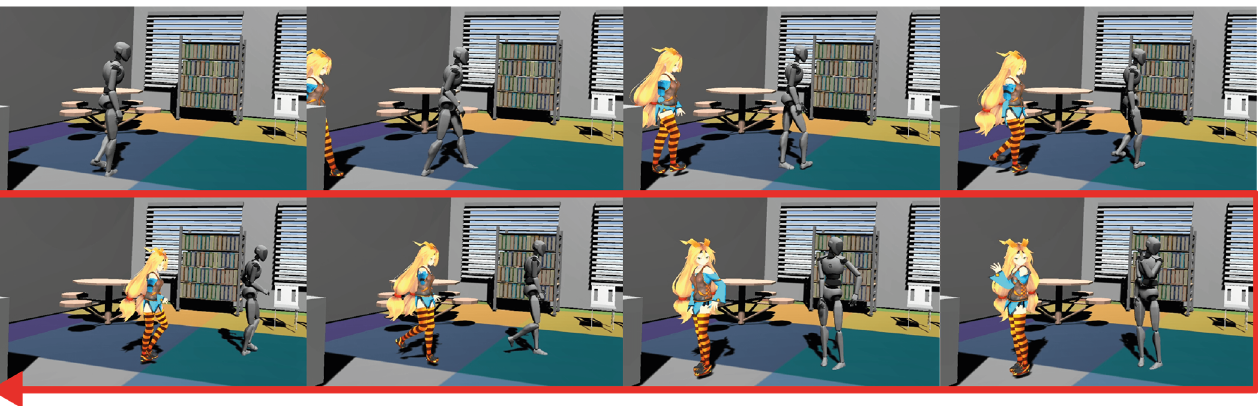
Figure 5. Real-time motion capture in Unity.